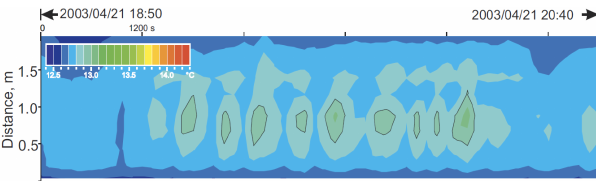
Figure 10. Temperatures in space–time domain during 110min of the A6a heating experiment where a long “train” of strong heat pulses is observed. The color coding is the same as in Figs. 4 and 5. Note the presence of concomitant pulses aside of the main